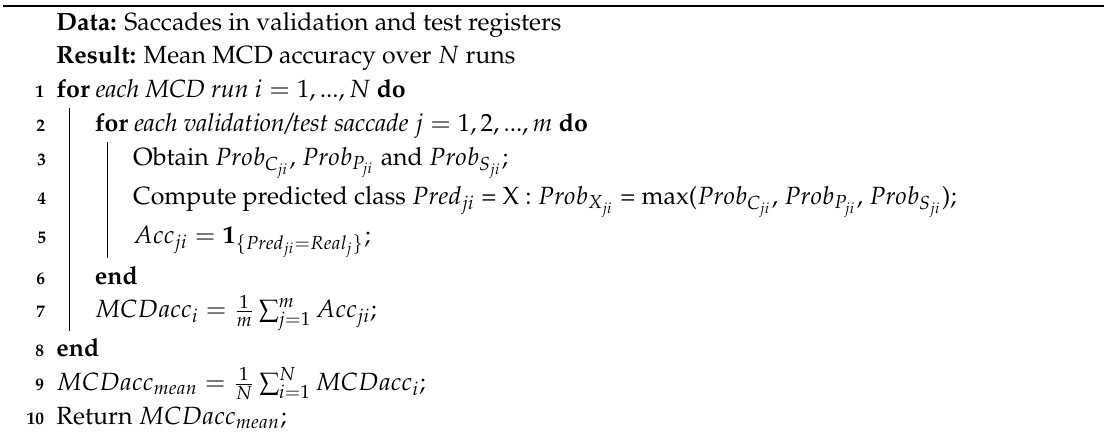
Algorithm 1: Calculation of class probabilities, labeling of individual saccades and computation of mean accuracy over the N runs of the MCD. This procedure is applied to both validation and test registers with constituent saccades Data: Saccades in validation and test